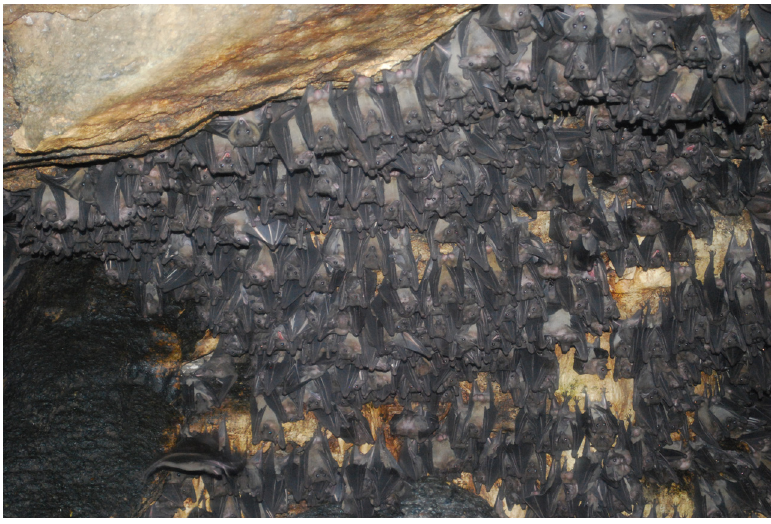
Figure 2. Marburg virus reservoir. Egyptian fruit bats ( Rousettus aegyptiacus ), the putative reservoir of MARV, roosting in the Python cave in Maramagambo Forest, Uganda. Two cases of MVD have been associated with visitors to this cave. Photo courtesy of Bobbie Rae Erickson, Viral Special Pathogens Branch, CDC,